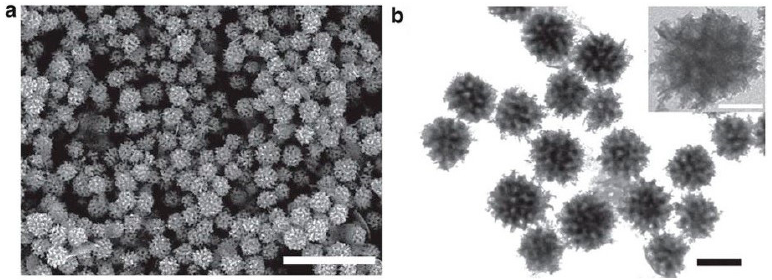
Figure 11. ( a ) SEM (scale bar 500 nm) and ( b ) TEM (scale bar 100 nm) images of mesoporous Rh NPs, reprinted from the [99] under a Creative Commons Attribution 4.0 International License.